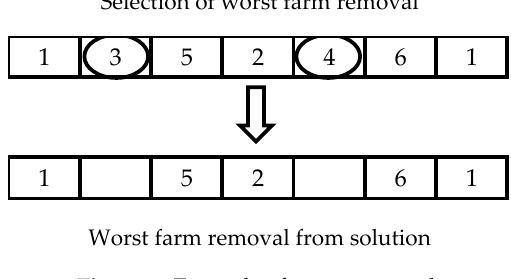
Figure 3. Example of worst removal.